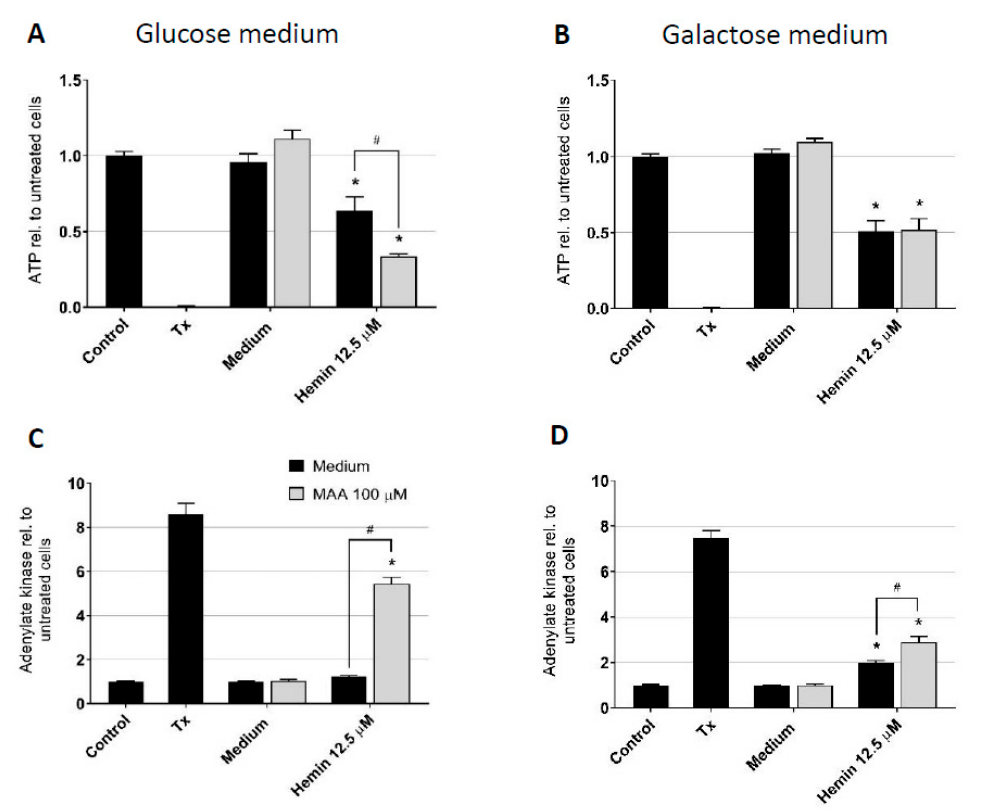
Figure 3. Influence of the culture conditions on the e ff ects of MAA and / or hemin on the cellular ATP content and plasma membrane integrity of HL60 cells. HL60 cells were treated with the toxicants for 24 h. Cells were cultured in the presence of 10 mM glucose or in the presence of 10 mM galactose in order to force the cells to mitochondrial ATP generation. ( A ) Cellular ATP content determined using the CellTiter-Glo ® luminescent assay in cells cultured in glucose. ( B ) Intactness of the plasma membrane of HL60 cells determined by the release of adenylate kinase into the supernatant in cells cultured in glucose. ( C ) Cellular ATP content determined using the CellTiter-Glo ® luminescent assay in cells cultured in galactose. ( D ) Intactness of the plasma membrane of HL60 cells determined by the release of adenylate kinase into the supernatant in cells cultured in galactose. Results are presented related to vehicle-treated control incubations. Tx = 0.1% Triton X used as positive control. n = 3 independent experiments in triplicate presented as the mean ± SEM. * p < 0.05 vs. vehicle-treated control incubations. # p < 0.05 vs. the corresponding value of incubations with hemin